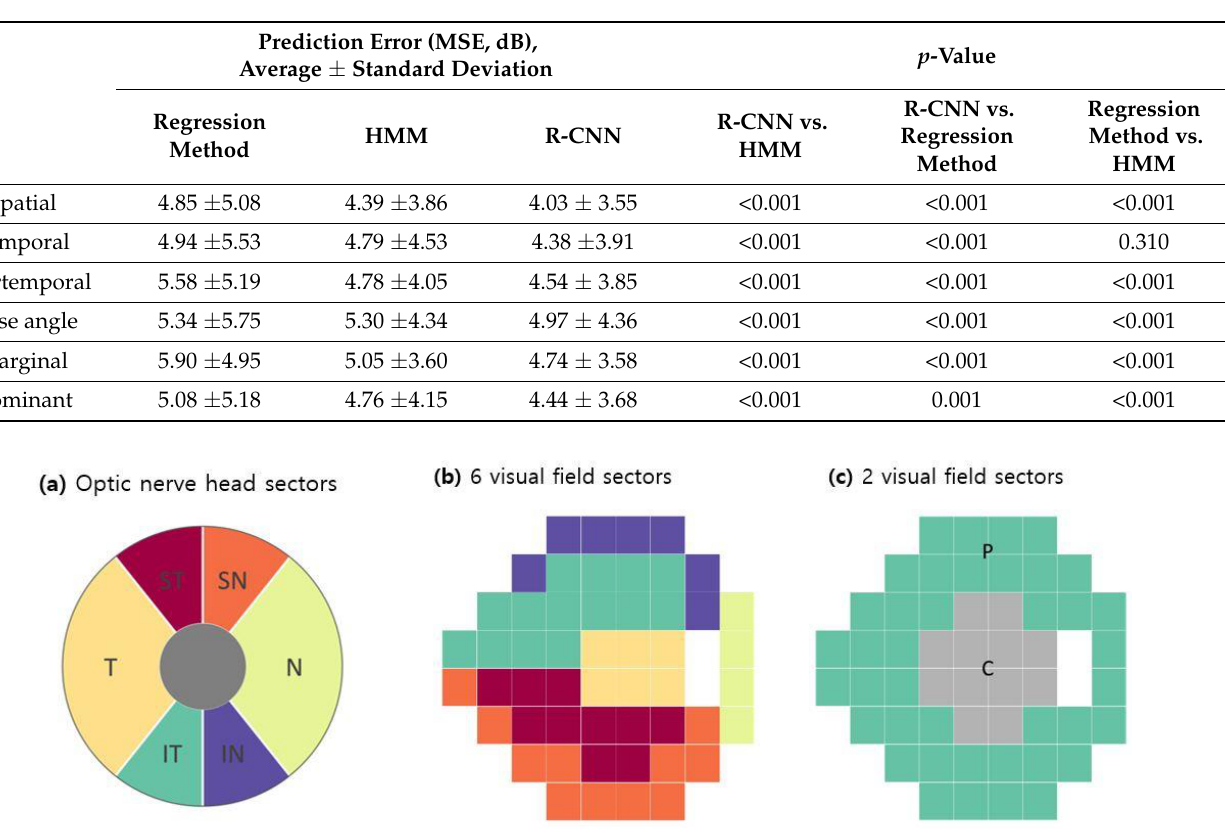
Figure 6. ( A ) Mean absolute error (MAE) of classified deviation value (DV). R-CNN had the least classification error (MAE) in most of the points. The more opaque hue indicates greater error. Red dots depict significant variances between the regression and R-CNN; blue dots depict significant variances between HMM and R-CNN (t-test). ( B ) Normalized squared error ( C ) Normalized absolute error. Table 10. The prediction error (MSE) by visual field partitions.